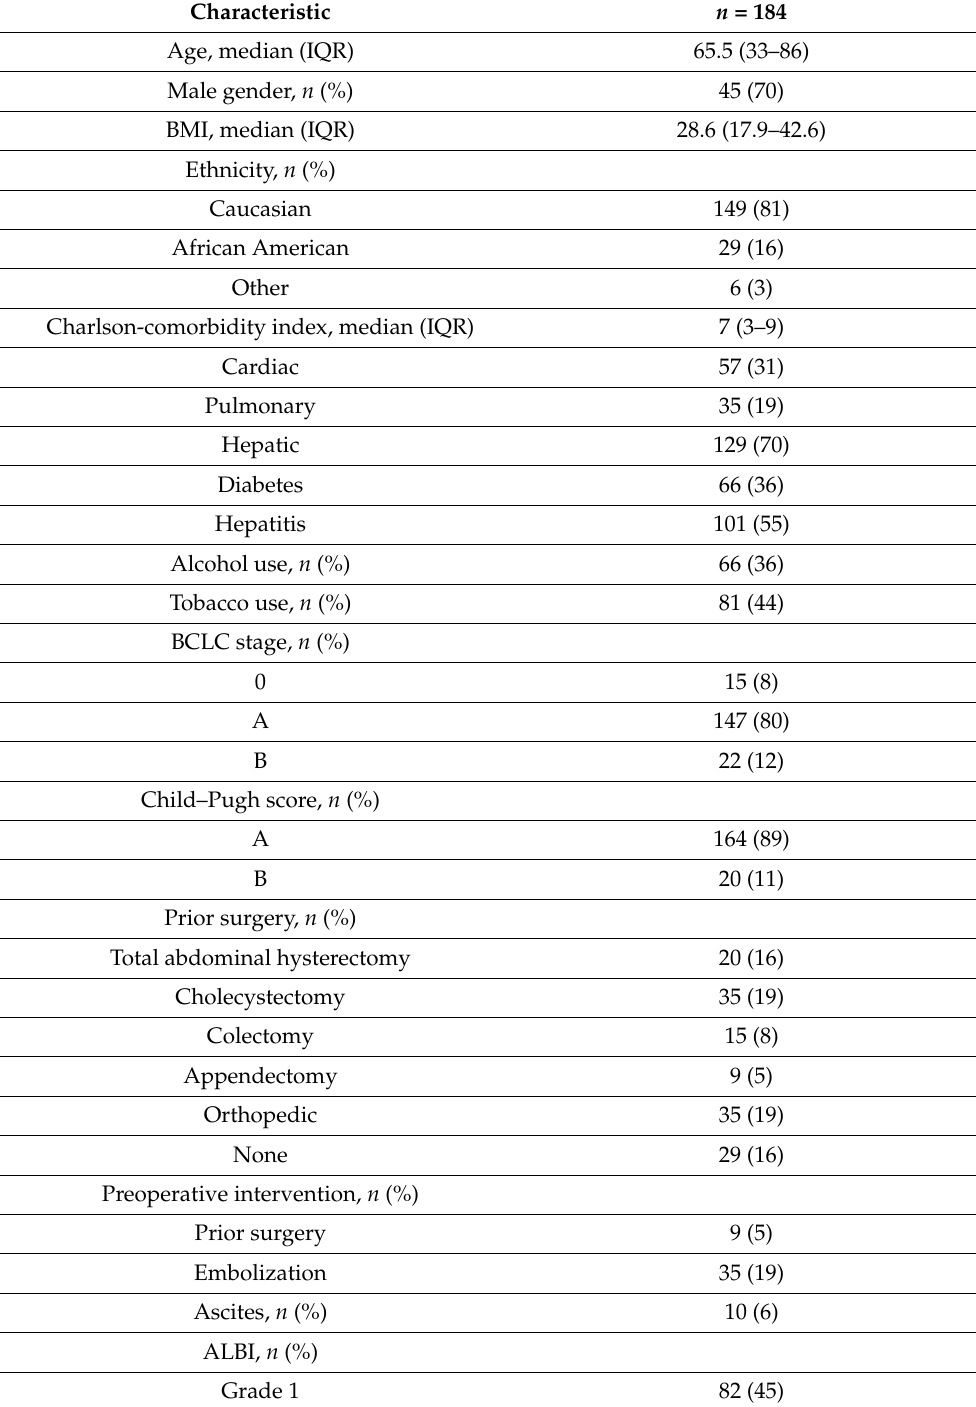
Table 1. Perioperative clinicopathologic details of the study